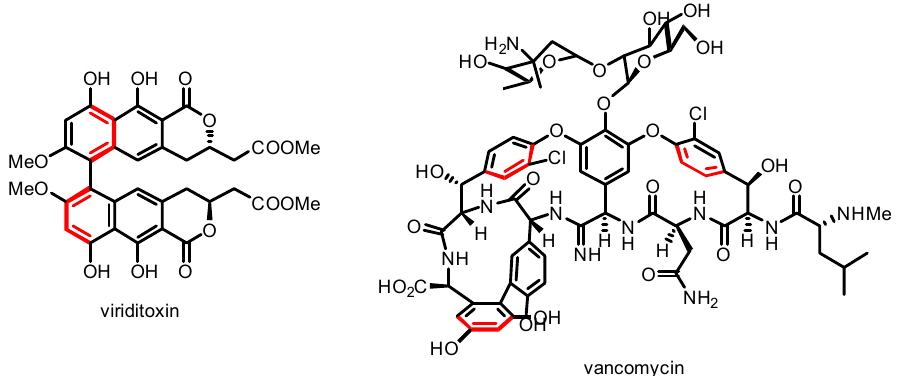
Figure 2. Examples of biologically active compounds with axial chirality.